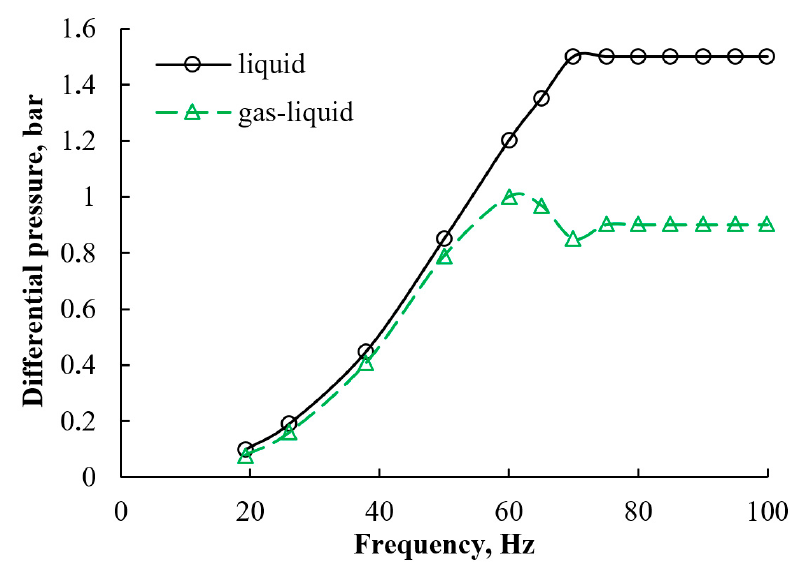
Figure 10. Pressure drop of the non-aerated and aerated water flow in the CLR.